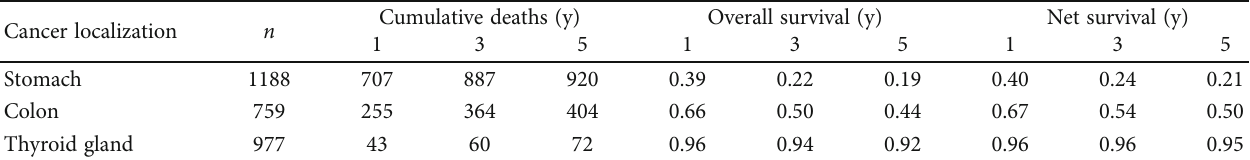
Figure 1: Schematic representation of the steps of the simulation process regarding simulating loss to follow-up. Time until death for four hypothetical cancer patients in this study; horizontal lines represent time from diagnosis with dots representing the date of death; the labels projected on top of the lines convey information regarding time under observation or to event in a 5-year survival analysis depending on the exact simulation step. (1) Complete cases, no simulation applied; (2) censured case scenario: randomly patients B and C were censored to be lost (simulating date of death was not reported by vital statistics, and therefore, patient erroneously considered alive at analysis point); time of patient B changed from 2.5 to 5.0 years, time of patient C unchanged by simulation as patient really did not decease; (3) excluded cases scenario: patients B and C in previous step changed to be lost to follow-up were excluded from analysis. Table 1: Numbers of complete cases available for analysis, number of cumulative deaths by time to follow-up, and 1-, 3-, and 5-year overall and net survival by cancer localization based on complete case